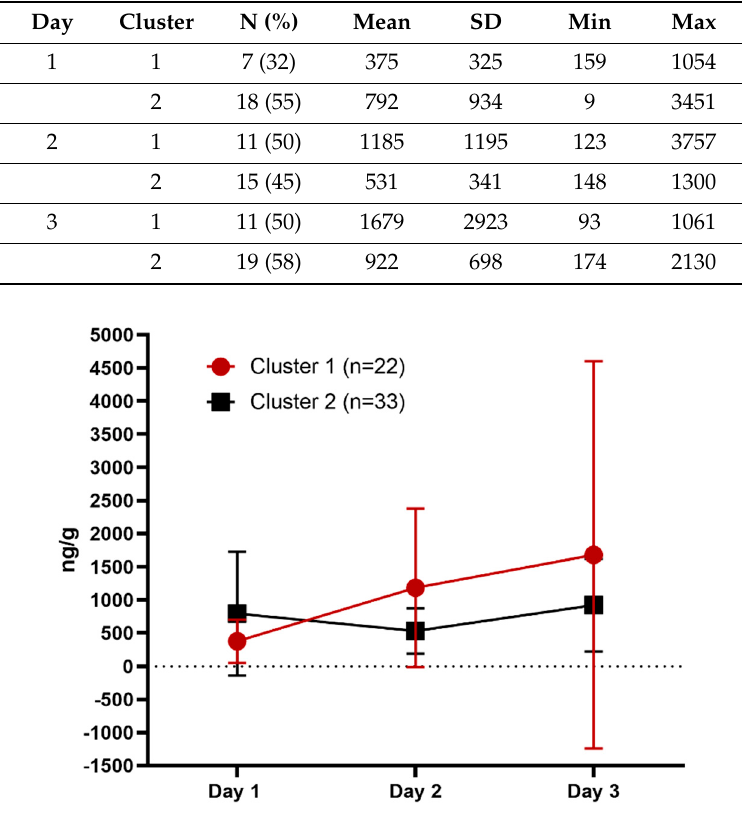
Figure 2. Fecal glucocorticoid metabolite (FGM) concentrations (ng / g) by cluster and day (mean and standard